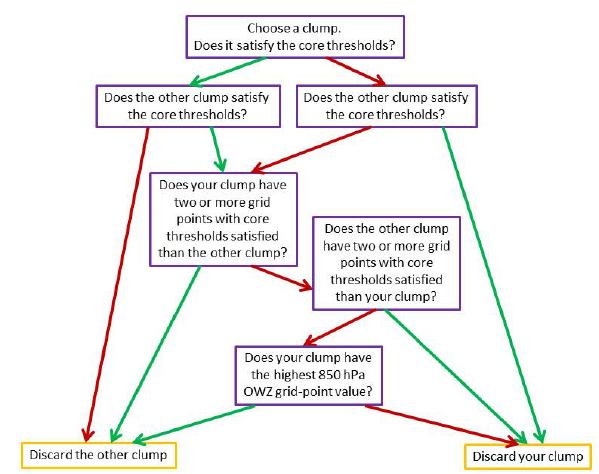
1 Fig. A1. Schematic illustration of the grid-point clump analysis. F IG . 7. Schematic illustration of the grid-point clump analysis. Grid points that satisfy the 2 Grid points that satisfy the initial thresholds are indicated by stars. initial thresholds are indicated by stars. Neighbouring grid points are grouped into clumps 3 Neighbouring grid points are grouped into clumps (circled and la- belled C1–C4). Clump 2 lies within a critical radius (dotted line) (circled and labelled C1—C4). Clump 2 lies within a critical radius (dotted line) of Clump 1. 4 of Clump 1. It is assumed that they belong to the same circulation, It is assumed that they belong to the same circulation, and for simplicity the weaker or smaller 5 and for simplicity the weaker or smaller clump is discarded (see Fig. A2). Clump 4 contains only one grid point. It will be included clump is discarded (see Fig. 8). Clump 4 contains only one grid point. It will be included in 6 in the track construction procedure (Fig. A3) but it will not meet the the track construction procedure (Fig. 9) but it will not meet the size requirement of the clump 7 size requirement of the clump conditions used in this paper. conditions used in this paper.8